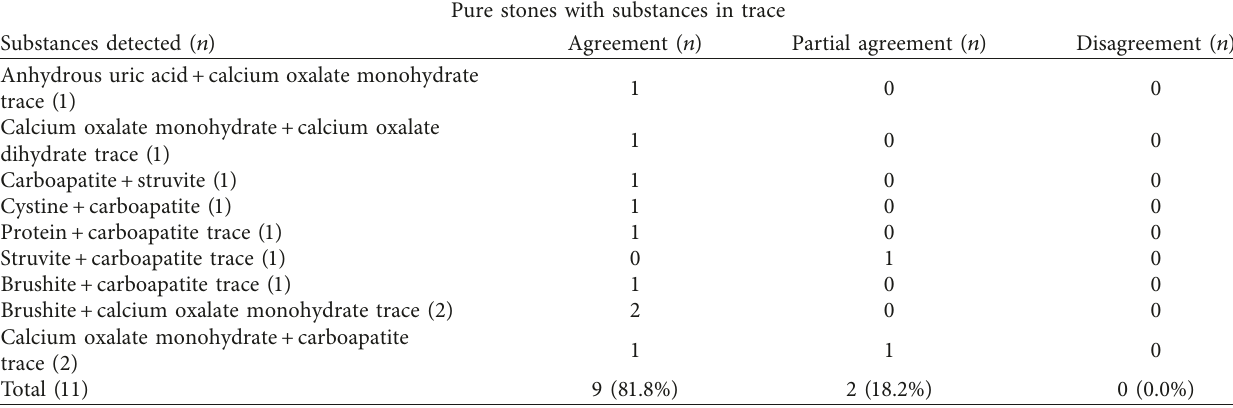
Table 3: Composition and agreement in pure stone with substances in trace group.